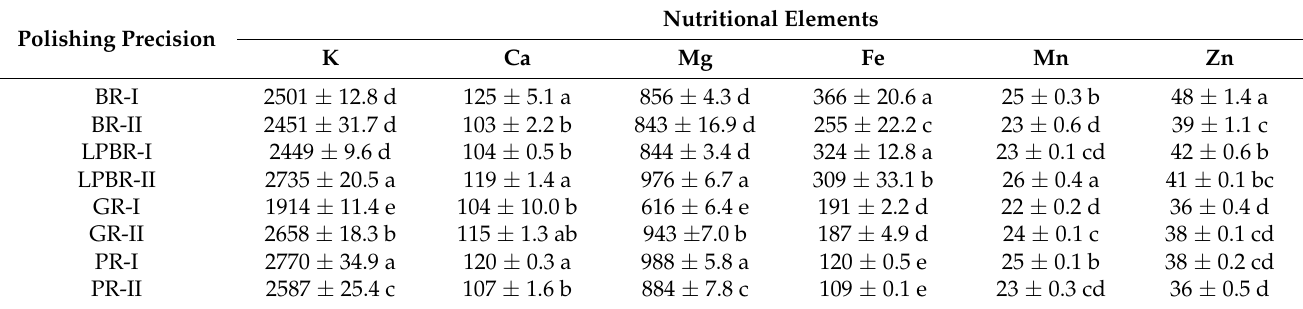
Table 1. Concentrations of mineral elements in rice with different polishing degrees (mg kg − 1 , dw, Mean ± SD, n =